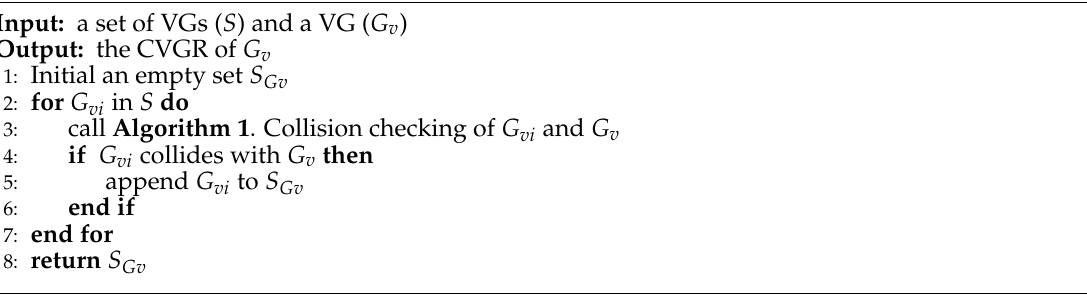
Algorithm 2 Calculation of the CVGR of A VG.